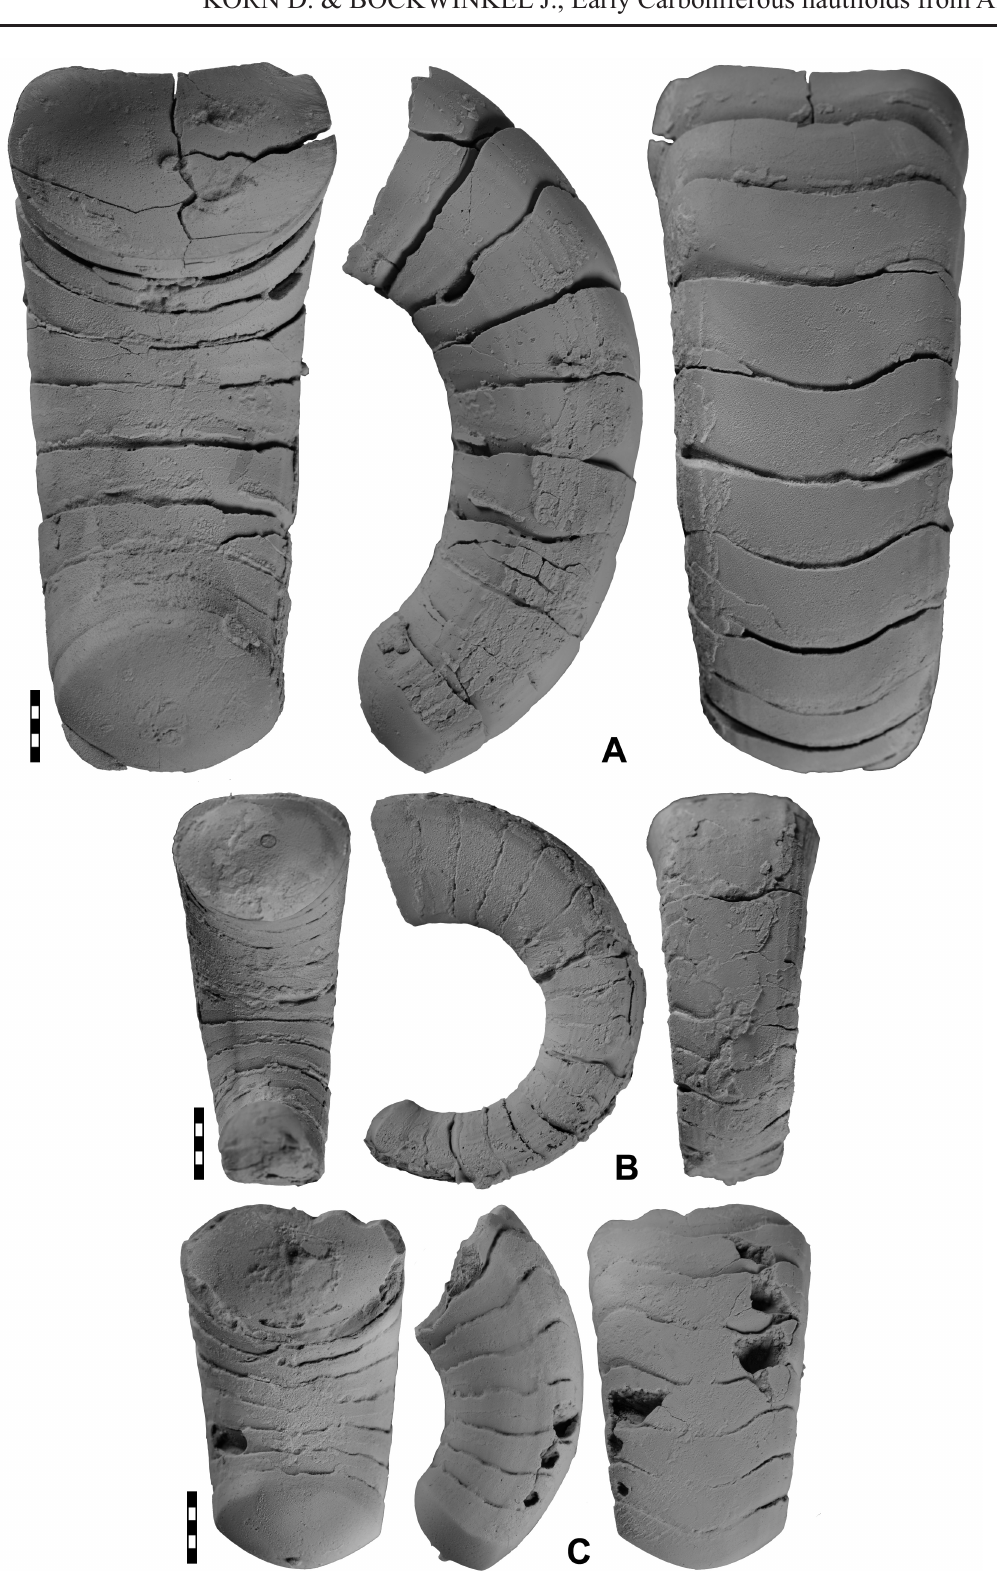
Fig. 4. Rineceras tenerum sp. nov. from Oued Temertasset (all Korn et al . 2002 Coll.). A . Holotype MB.C.30440.1 (larger segment). B . Holotype MB.C.30440.1 (smaller segment). C . Paratype MB.C.30441. Scale bar units = 1